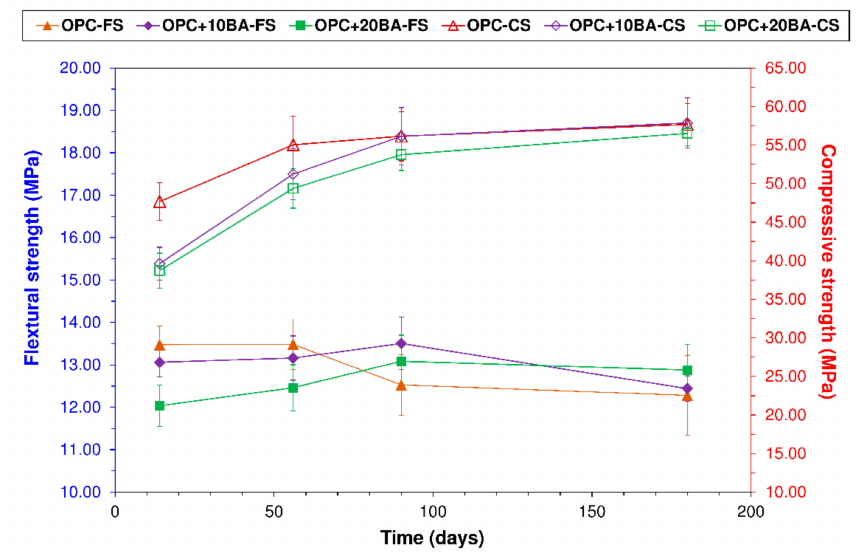
Figure 1. Mechanical behaviour of cement pastes soaked in a 0.3 M Na 2 SO 4